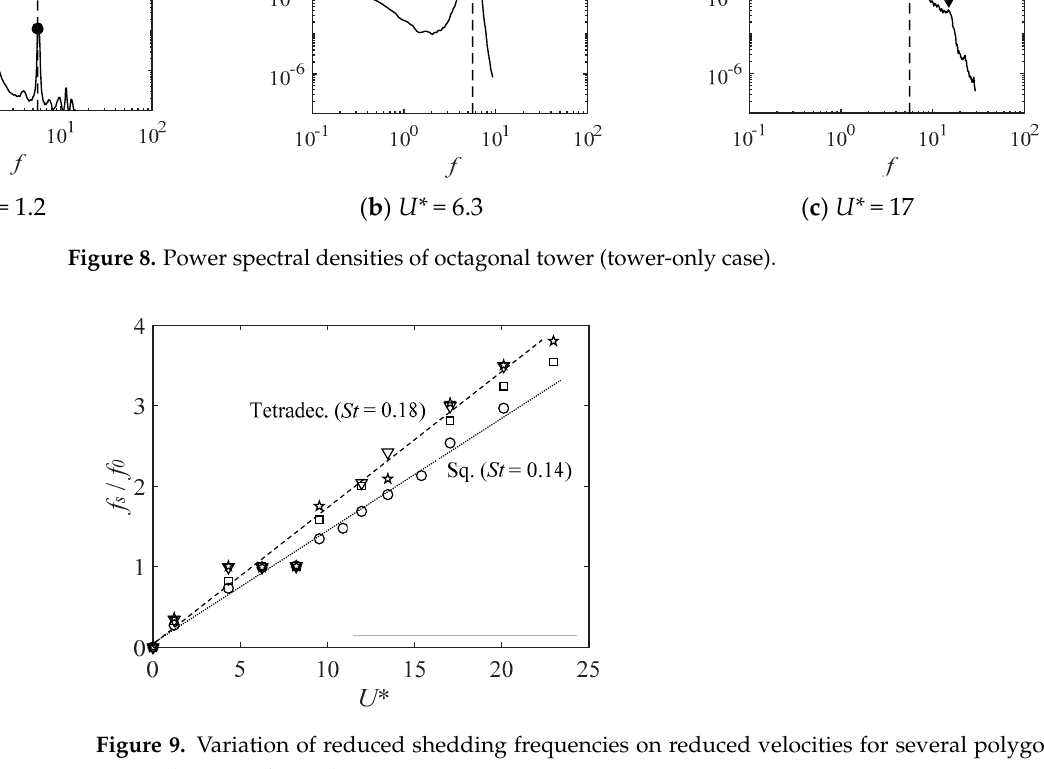
( c ) Circular tower Figure 10. Power spectral densities of wind turbine installed on various polygonal towers at θ wd = 0° and θ azi = 0°. 3.3. Local Force Coefficients from Pressure Measurements As previously mentioned, pressures on towers were measured by simultaneous multi-channel pressure sensing systems. Pressure taps were installed along the tower